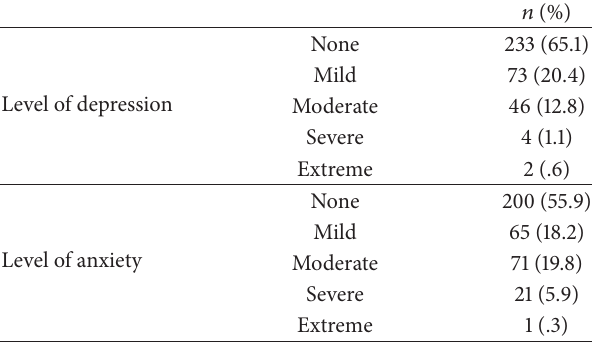
Table 1: Prevalence of levels of depression and